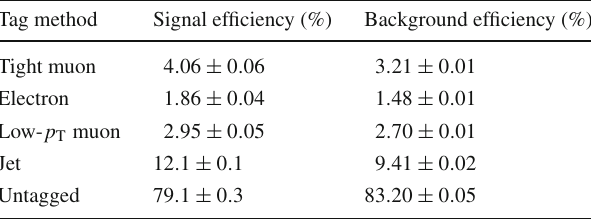
Table 3 Fractions of signal and background events tagged using the different methods. The efficiencies include both the continuous and discrete contributions. Only statistical uncertainties are